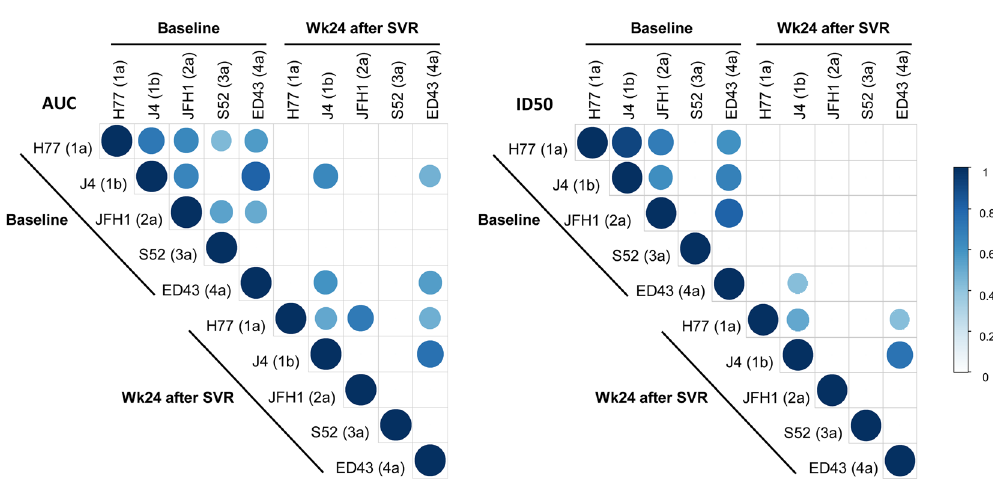
Figure 3. Summary of relevant correlation coefficients (r > 0.4; p < 0.05) among HCV-nAb titers against recombinant viruses in HIV/HCV-coinfected patients at baseline and 24 weeks after sustained virological response. The correlation coefficients are denoted by the intensity of the color and the size of the circle. Abbreviations: AUC, area under the curve (arbitrary units); ID50, 50% inhibitory dose; SVR, sustained virological response; Wk, week. Statistics: Correlation coefficients and p-values were calculated by the test of Spearman’s correlation